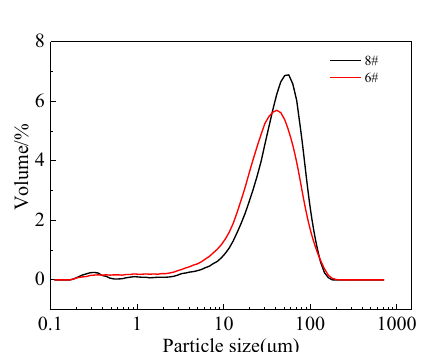
Figure 7: Particle size distribution curve of 6# and 8#